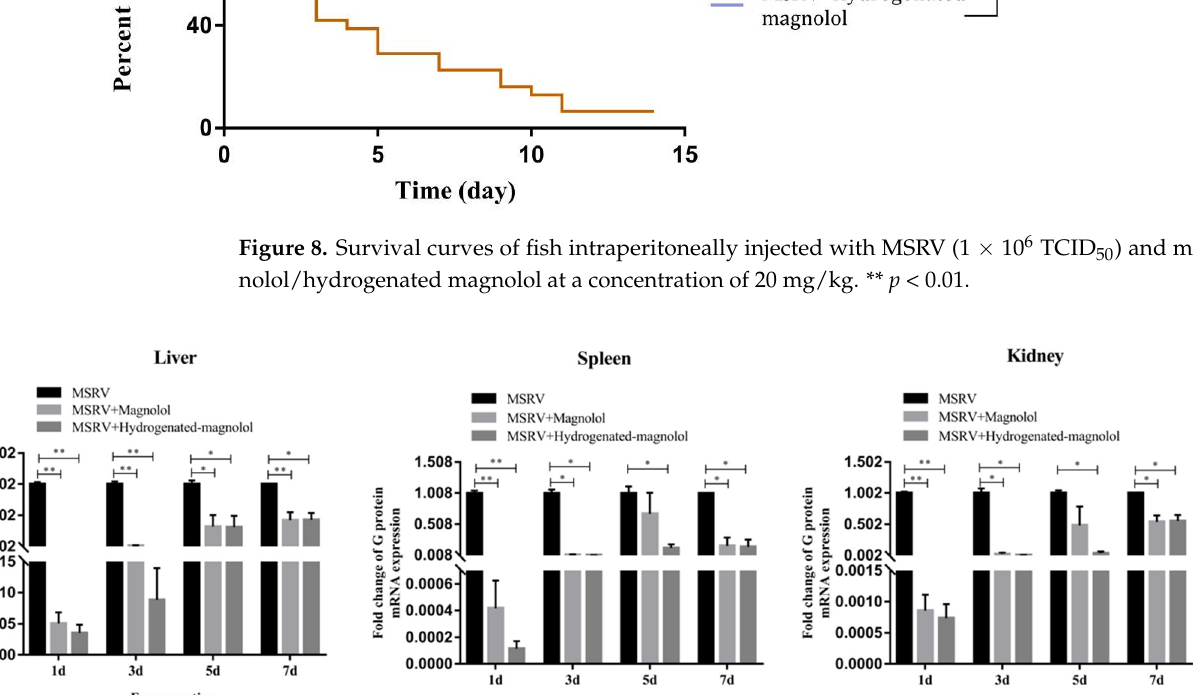
Figure 8. Survival curves of fish intraperitoneally injected with MSRV (1 × 10 6 TCID 50 ) and magno- lol/hydrogenated magnolol at a concentration of 20 mg/kg. ** p < 0.01.